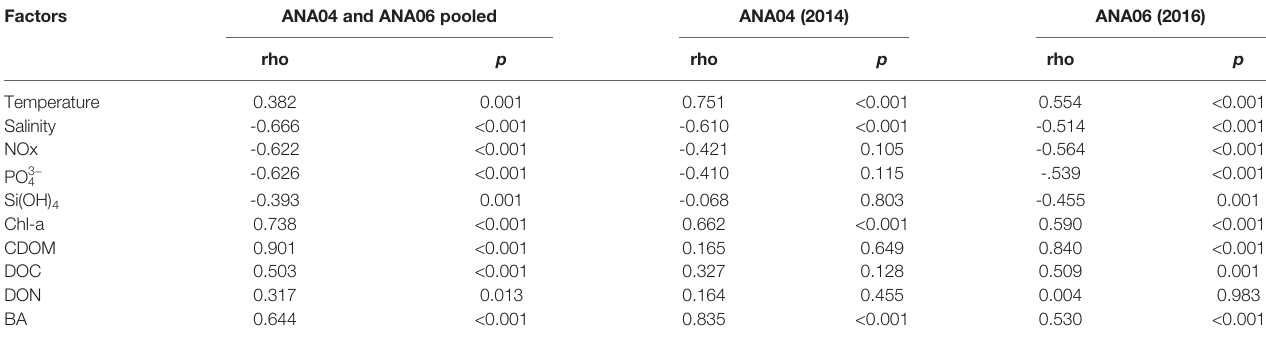
TABLE 3 | Spearman ’ s correlation between bacterial production and environmental factors in ANA04 and ANA06 (upper 100 m).